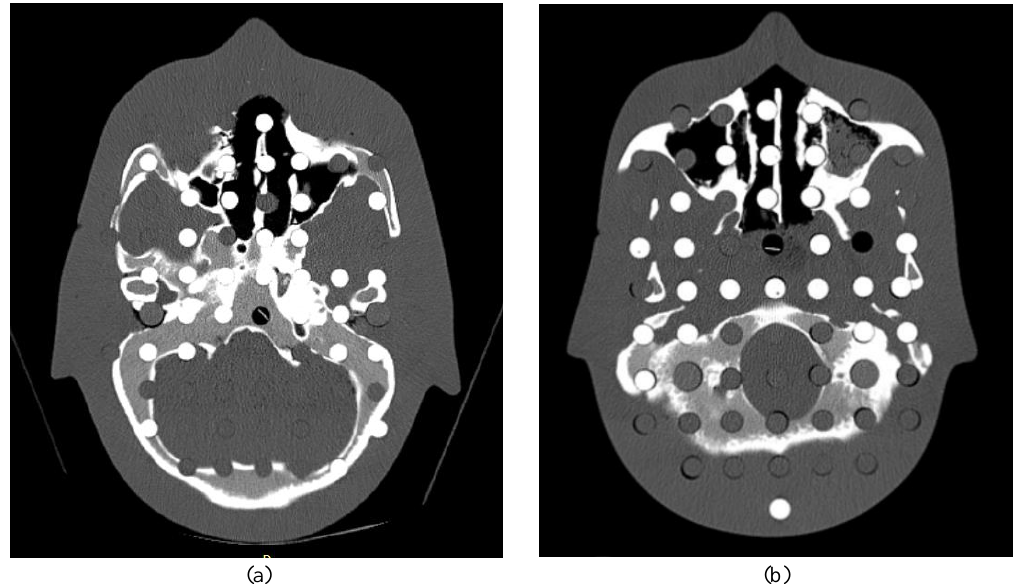
Figure 3. CT head images of (a) male and (b) female anthropomorphic phantoms Table 3. Noise percent from CT images of anthropomorphic